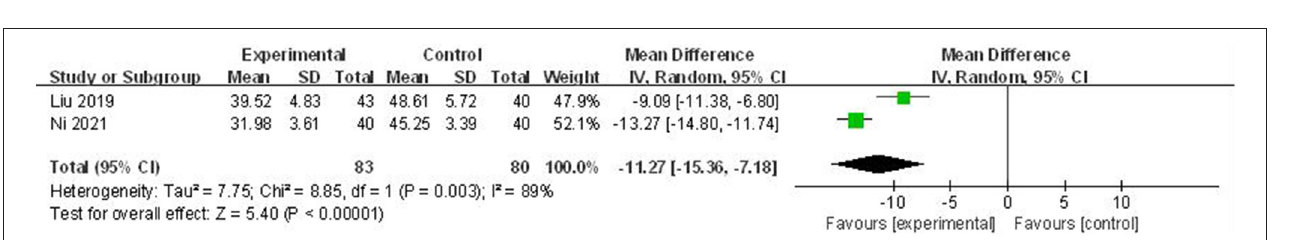
FIGURE 5 | Forest plots of acupuncture plus standard treatment vs. standard treatment: pain relief rate.